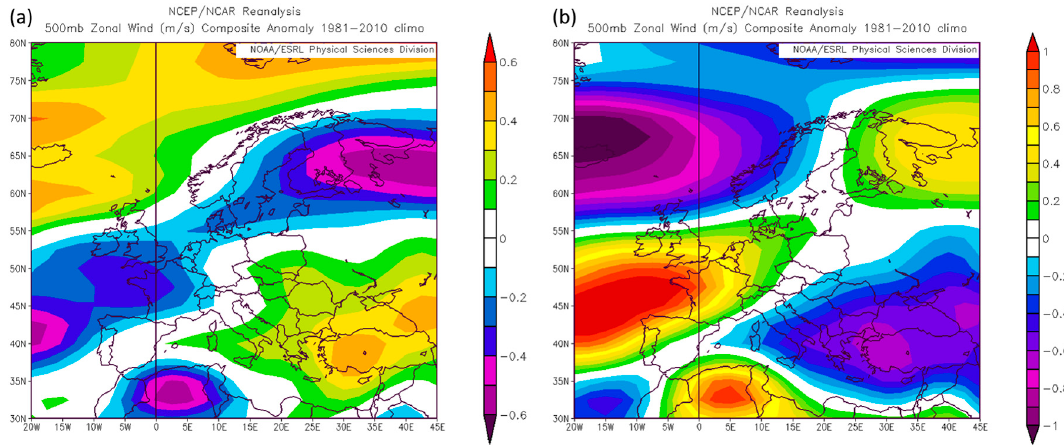
Figure 4. 500 hPa zonal wind (m/s) composite anomaly maps (reference period 1981–2010) referred to May–September of the sub-periods 1980–1997 ( a ) and 1998–2015 ( b ) obtained by using NCEP/NCAR Reanalysis [52].